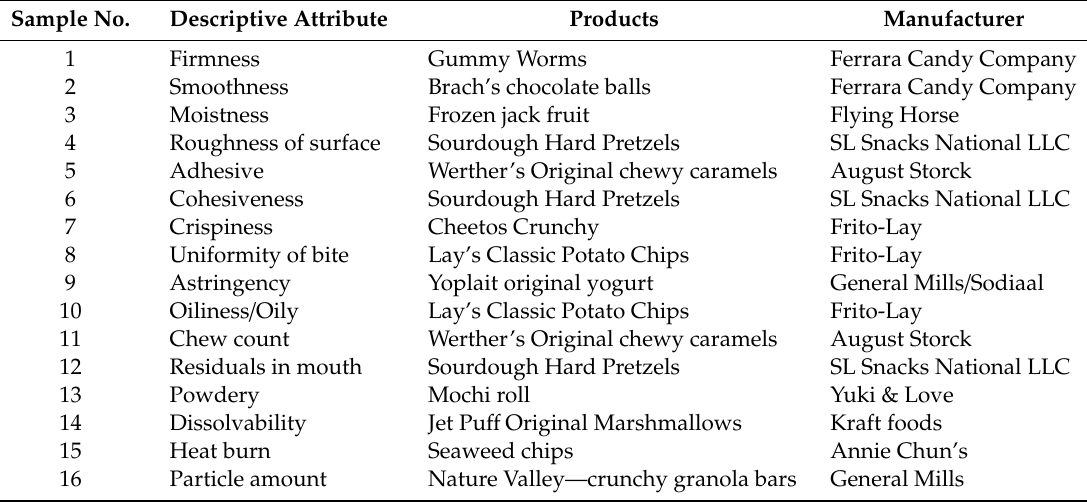
Table 2. List of food samples served to consumers for each texture attribute. Sample